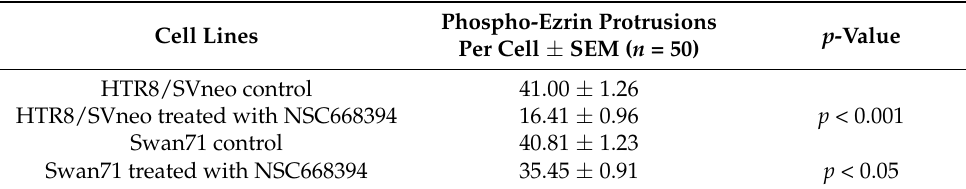
Table 2. Inhibiting ezrin phosphorylation with NSC668394 leads to much greater reductions in cellular protrusions in HTR8/SVneo than in Swan71 trophoblast